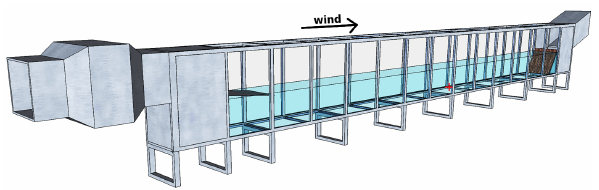
Fig. 2. Schematic view of the flume section of the Kyoto high-speed wind-wave tank. Not shown is the radial fan producing the wind (left side). The red cross marks the approximate sampling